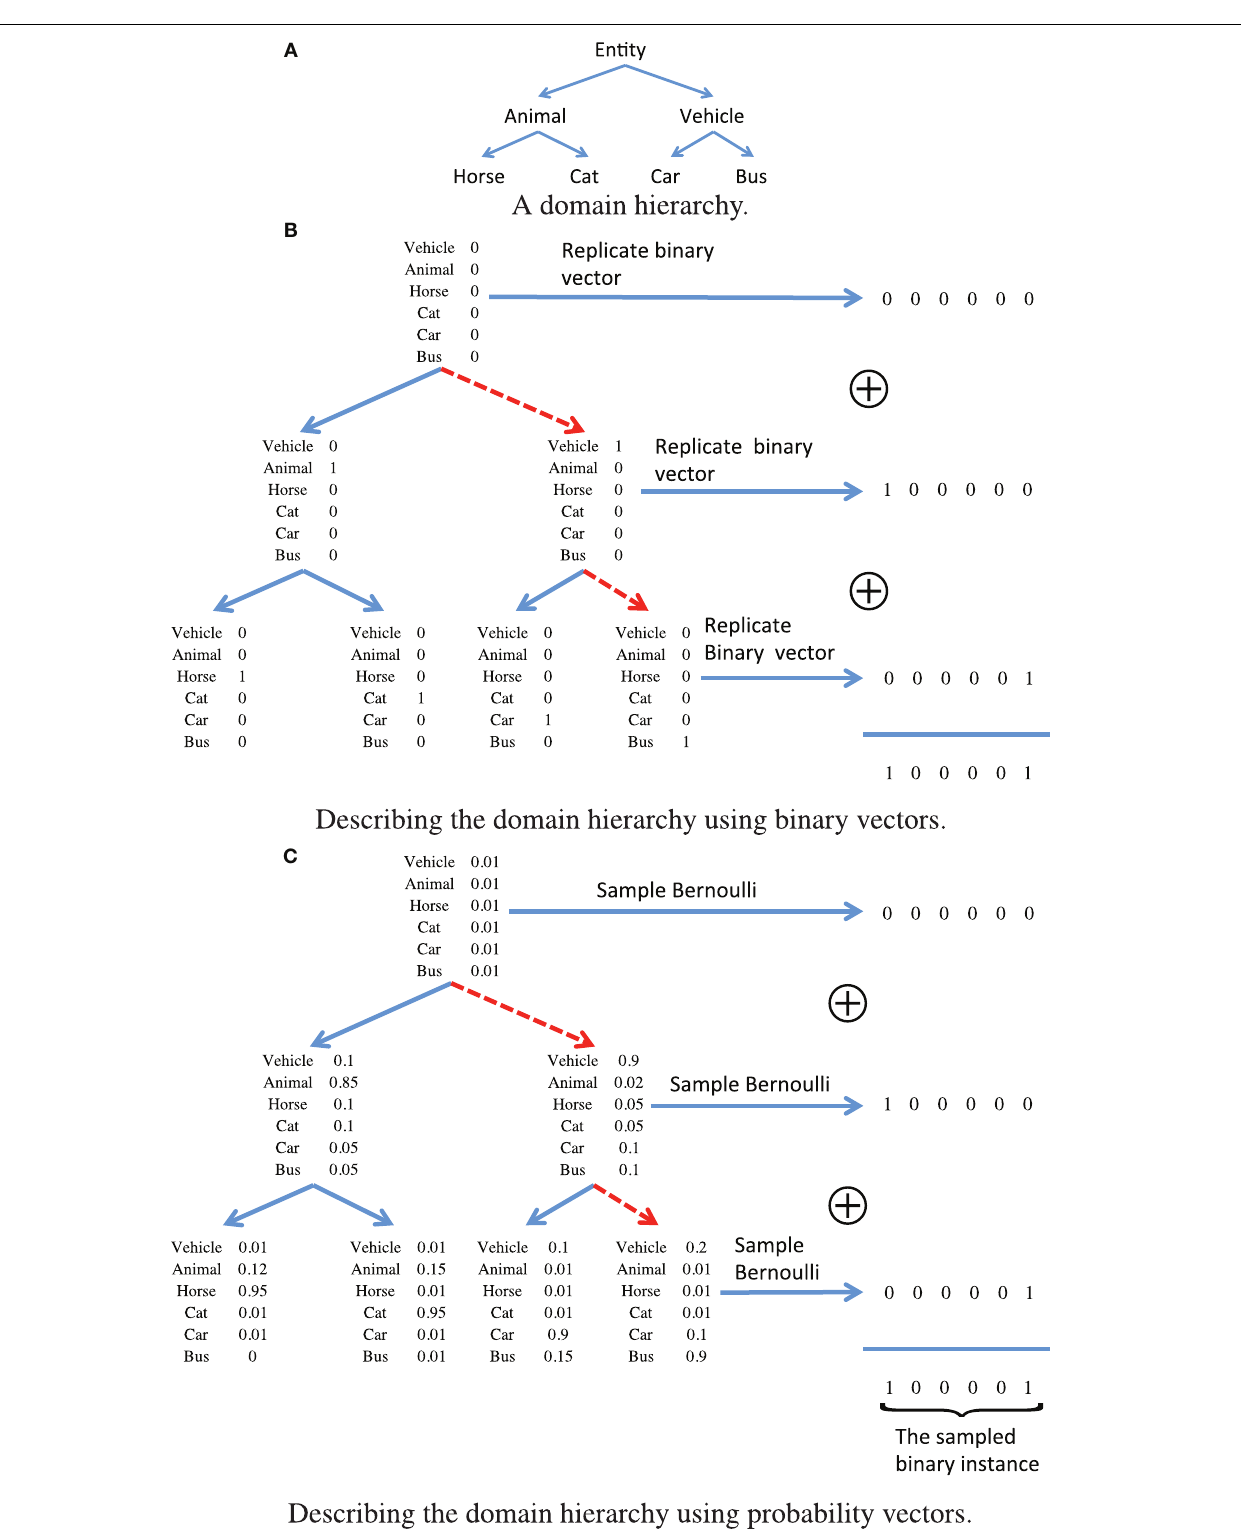
FIGURE 1 | An illustrative example of representing the (A) domain hierarchy using (B) binary vectors, and (C) using a relaxed probabilistic interpretation.